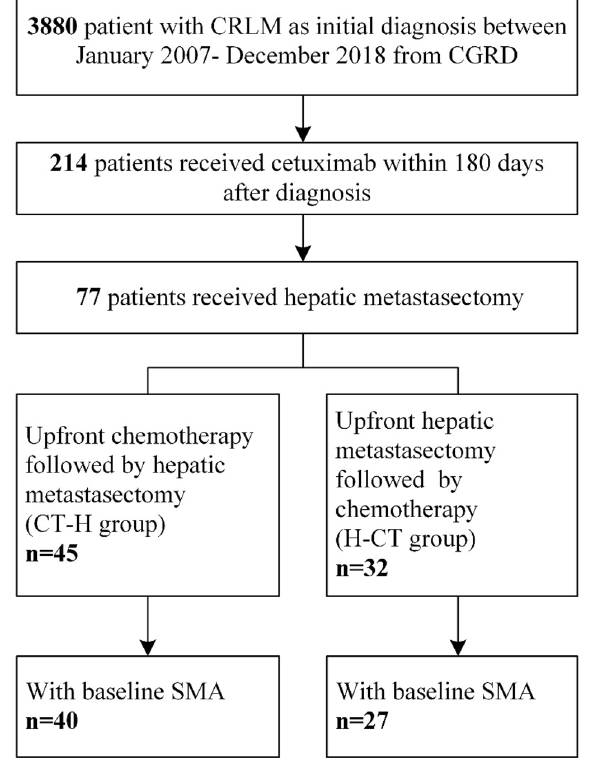
Figure 1. Step-wise inclusion process.